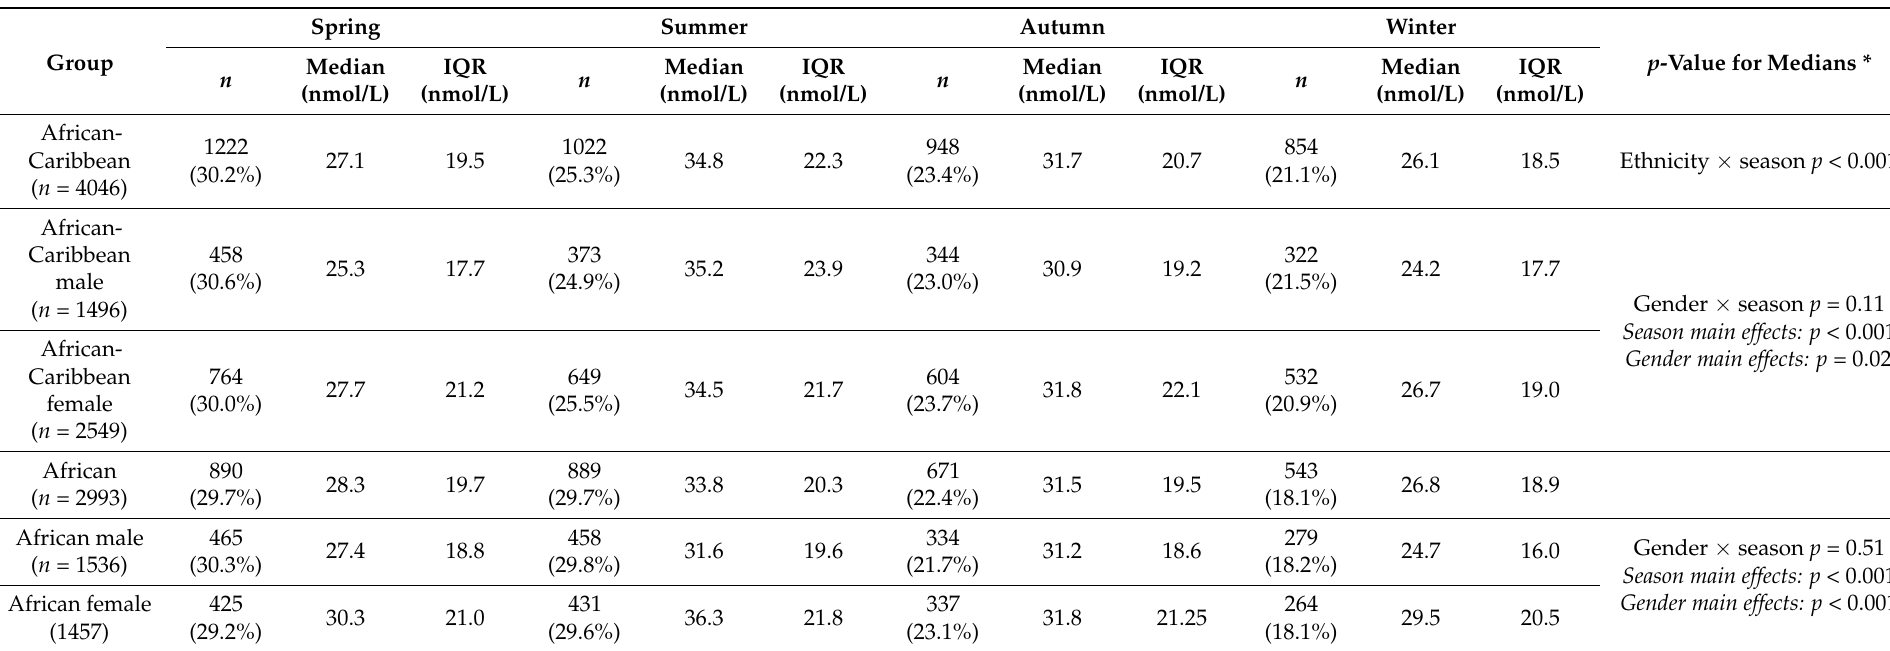
Table 3. Serum 25(OH)D by season and ethnicity for the African-Caribbean ( n = 4046) and African ( n = 2993) participants from the UK Biobank. Spring Summer Autumn Group